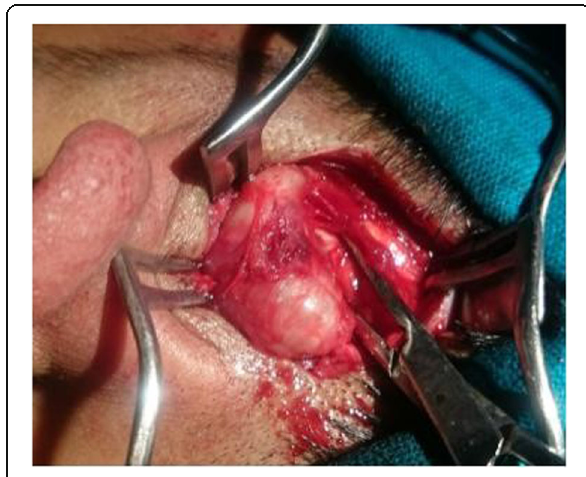
Fig. 2 Intraoperative photograph showing the epidermal inclusion cyst in the temporal fossa deep to the anterior fibres of the temporalis muscle